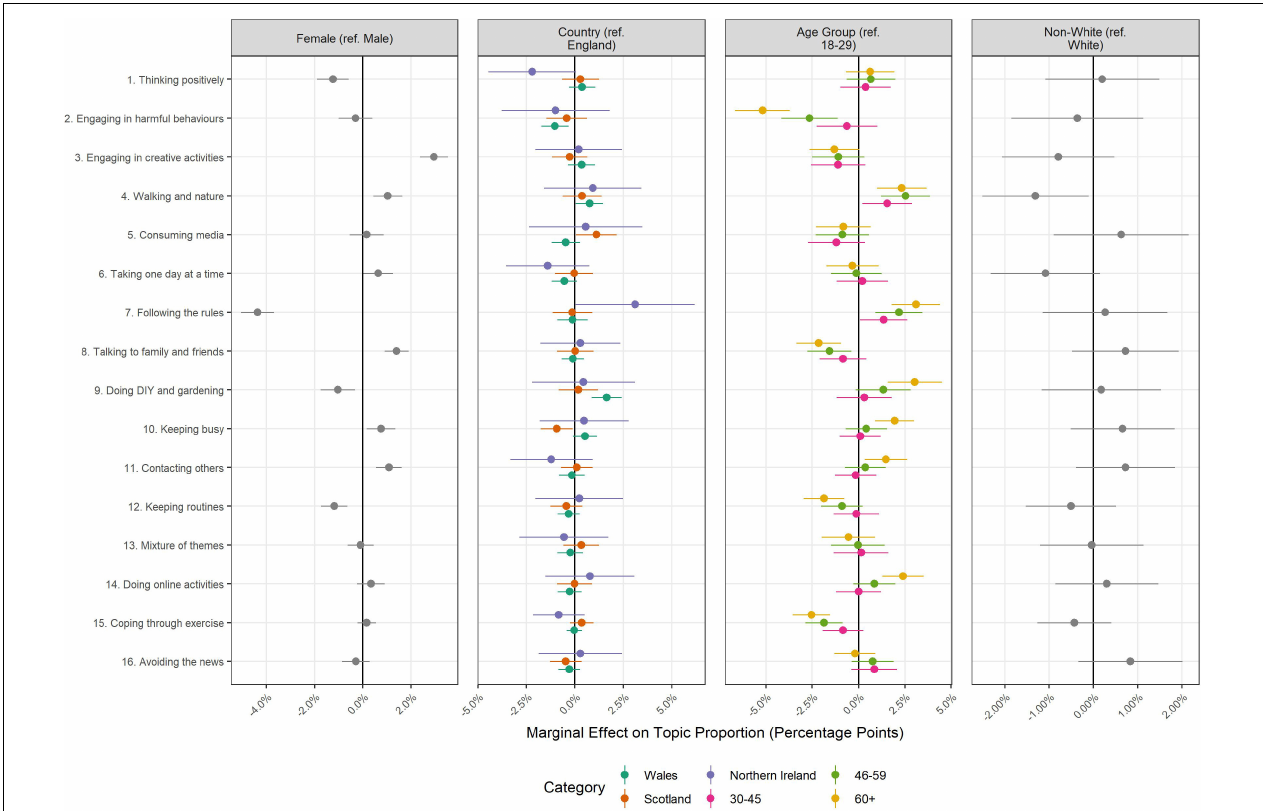
FIGURE 4 | Association between document topic proportion and demographic characteristics (+95% confidence intervals). Results displayed as marginal effects (difference in topic proportion according to change in independent variable). Derived from OLS regression models including adjustment for gender, ethnicity, age, education level, living arrangement, psychiatric diagnosis, long-term physical health conditions, self-isolation status, Big-5 personality traits and keyworker status. Reference categories are provided in the plot